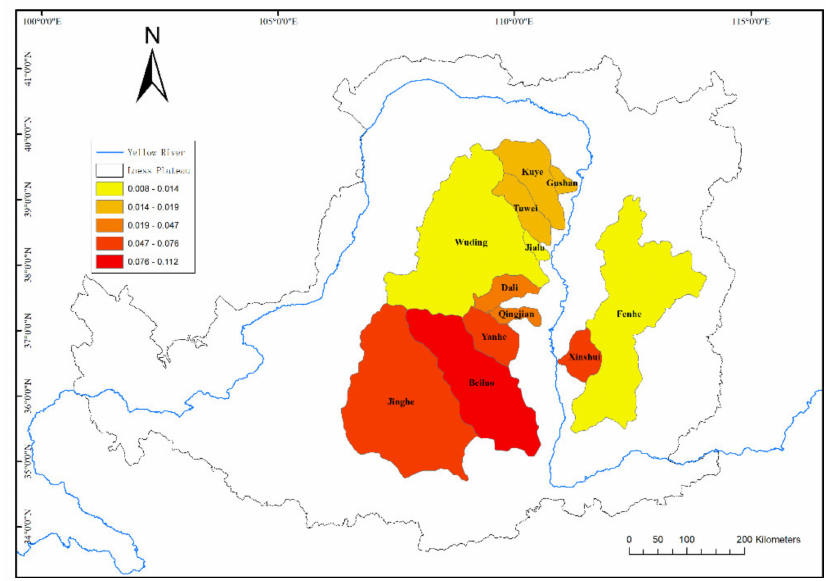
Figure 4. Map of the standard deviation (Std) of different Budyko-based methods for quantifying human and climate contributions to